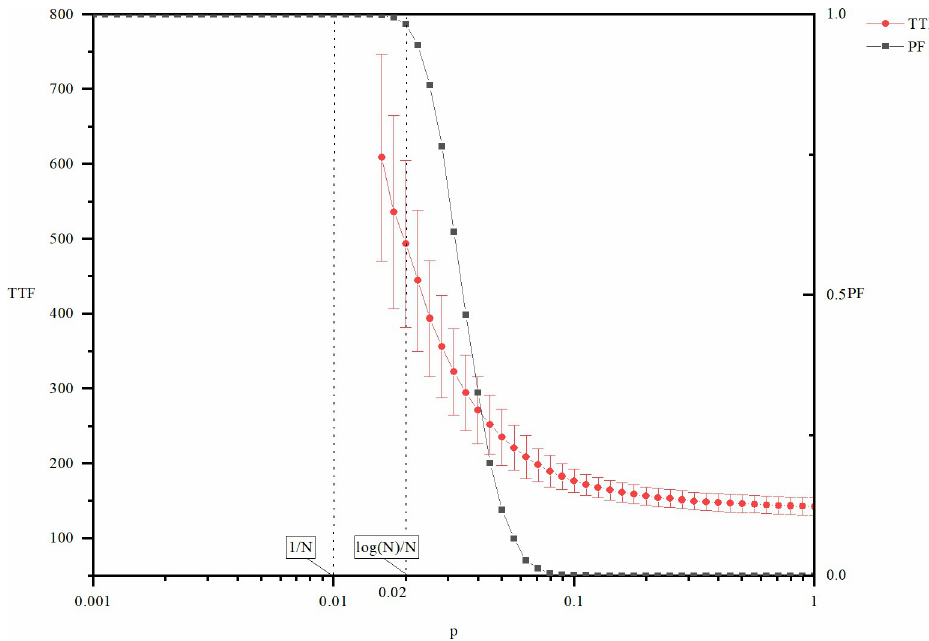
Fig 2. TTF and PF of explorative innovation as a function of